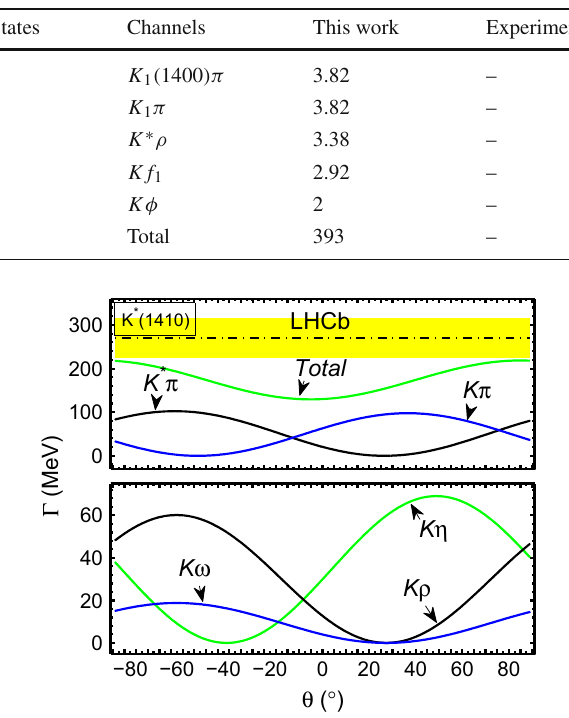
Fig. 1 The θ sd dependence of the total and partial decay widths of K ∗ ( 1410 ) . Here, the dot-dashed line is the experimental value